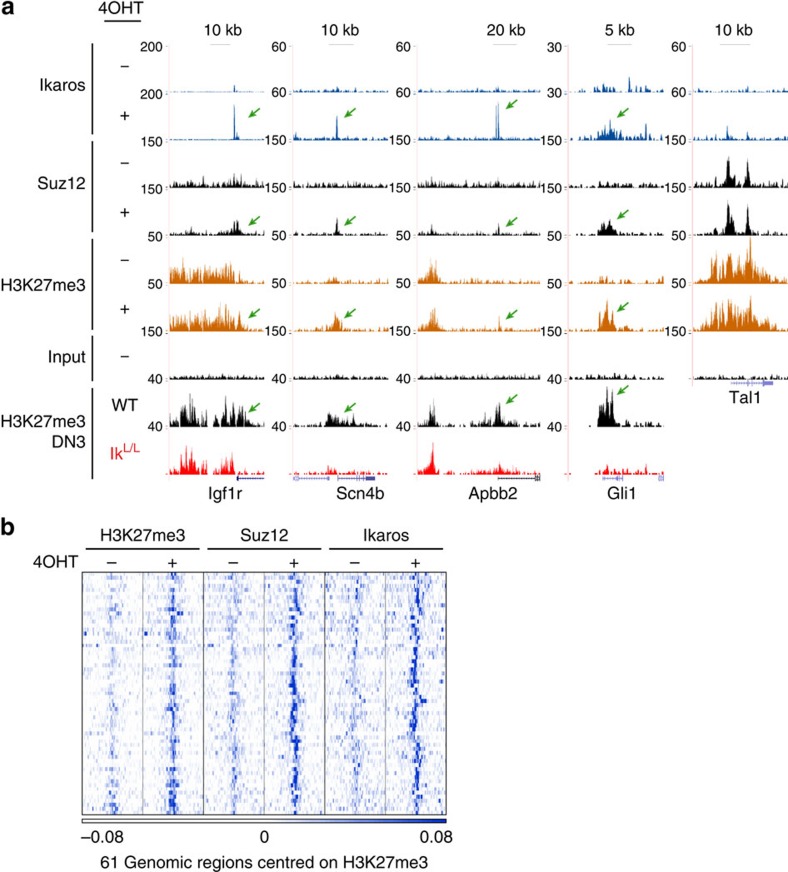
Ikaros induces PRC2 targeting and H3K27 trimethylation.ChIP-seq of Ikaros, Suz12 and H3K27me3 on ILC87-Ik1-ER cells treated with 4OHT (+) or ethanol (−) for 1 day (Ikaros) or 3 days (Suz12 and H3K27me3). (a) Representative genome browser tracks. Green arrows depict induced Ikaros, Suz12 and H3K27me3. Corresponding H3K27me3 tracks from primary WT and IkL/L DN3 thymocytes are shown at the bottom. Tal1 is shown as positive control. Vertical scales indicate tag numbers. (b) k-means clustering of H3K27me3-centred (±10 kb) Ikaros, Suz12 and H3K27me3 tag density heatmaps on the 61 regions with increased H3K27me3 in 4OHT-treated samples. Selected regions were identified bioinformatically (as having an Ikaros peak in 4OHT-treated cells, which overlapped with a H3K27me3 island that increased >1.8 × between ethanol- and 4OHT-treated cells), or by visual scanning of the tracks.